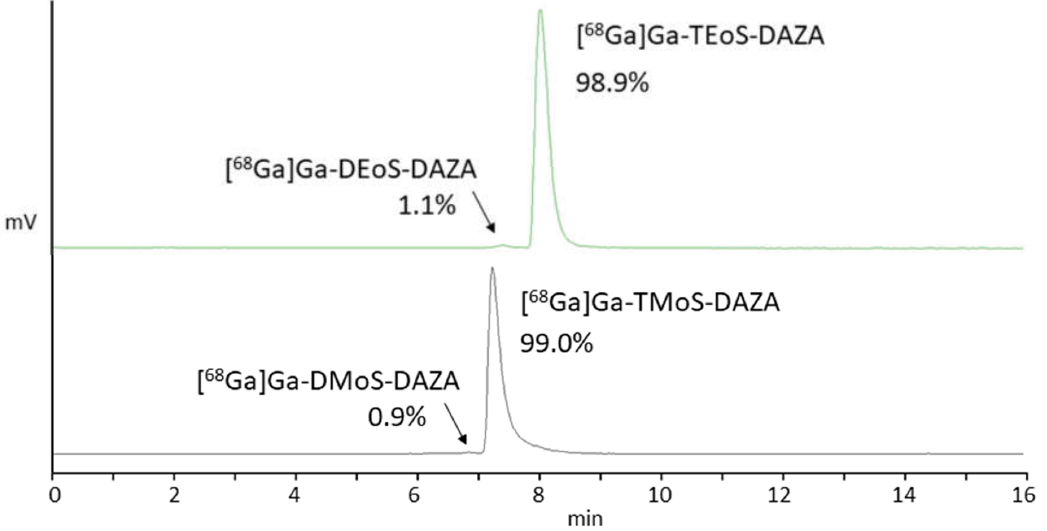
Figure 3. Representative radio HPLC chromatograms of [ 68 Ga]Ga-TEoS-DAZA (green, top) and [ 68 Ga]Ga-TMoS-DAZA (black, bottom) in the final formulation after SPE purification. Arrows point to the respective by-products [ 68 Ga]Ga-DEoS-DAZA and [ 68 Ga]Ga-DMoS-DAZA.